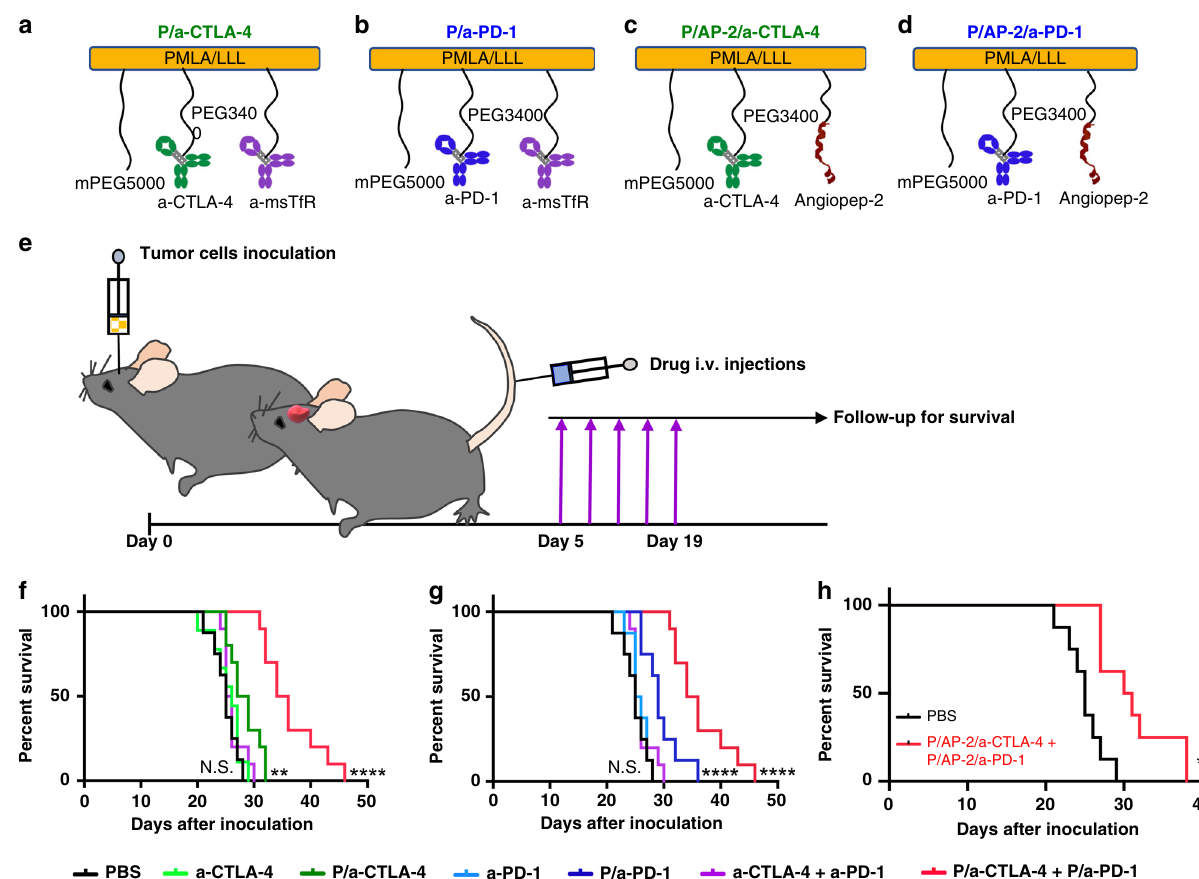
Fig. 7 Increased GL-261-bearing animal survival after treatment with NICs. a – d Structures of treatment nanoconjugates containing PMLA/LLL as a backbone, 2% mPEG5000, a-msTfR (or AP-2), and a-CTLA-4 or a-PD-1. e Schematic depicting experiment work fl ow: tumor cells are inoculated intracranially; fi ve I.V. drug treatments are started 5 days after inoculation after which animals ( N = 10 per group) are followed for survival. Kaplan – Meier plot of animal survival after treatment with f , PBS, a-CTLA-4, P/a-CTLA-4, a-CTLA-4 + a-PD-1, and P/a-CTLA-4 + P/a-PD-1. Treatment with P/a-CTLA-4 and P/a-CTLA-4 + P/a-PD-1 signi fi cantly increases survival compared with free antibodies, their combination and PBS. g Treatment with PBS, a-PD-1, a- CTLA-4 + a-PD-1, P/a-PD-1, and P/a-CTLA-4 + P/a-PD-1. Both NIC treatments signi fi cantly improve survival compared to free antibodies, their combination and PBS. h Treatment with PBS, and P/a-CTLA-4 + P/a-PD-1. This experiment was performed with AP-2 peptide to cross BBB as an alternative to a-TfR antibody. NIC treatment signi fi cantly improves survival compared to PBS. Data are mean ± SEM, N = 6 per group. p -Values were obtained using a log-rank test where ** p < 0.01; **** p < 0.0001; N.S. = non-signi fi